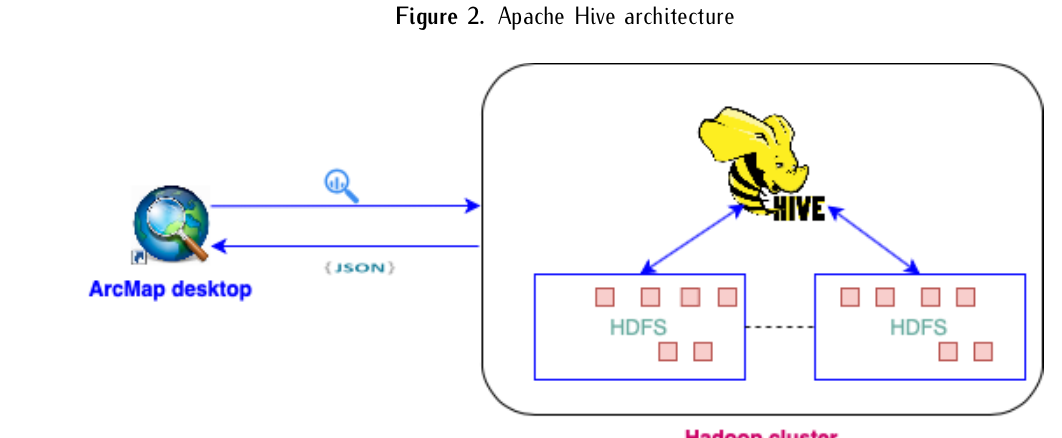
Figure 2. Apache Hive architecture